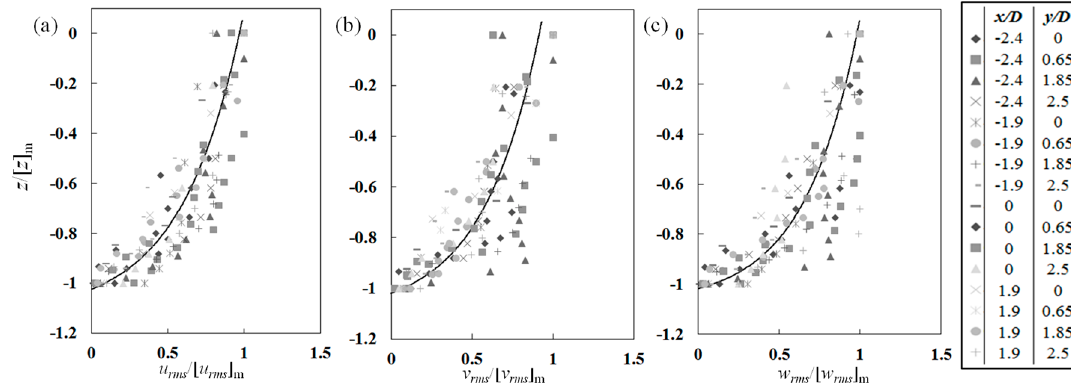
Figure 16. Similarities of the profiles of turbulence intensity components: ( a ) u rms , ( b ) v rms , and ( c ) w rms . The extreme values of turbulence intensity components (i.e., [ u rms ] m , [ v rms ] m , and [ w rms ] m ) for each vertical line at the sections of x / D = − 2.4, − 1.9, 0, and 1.9 along y / D are shown in Figure 17. The values of [ u rms ] m and [ v rms ] m were significantly larger by about 2–3 orders of magnitude than the values of [ w rms ] m in all locations. With the increase of y / D , the disturbance by the piles was weakened, therefore the extreme value of the turbulence intensities decreased.